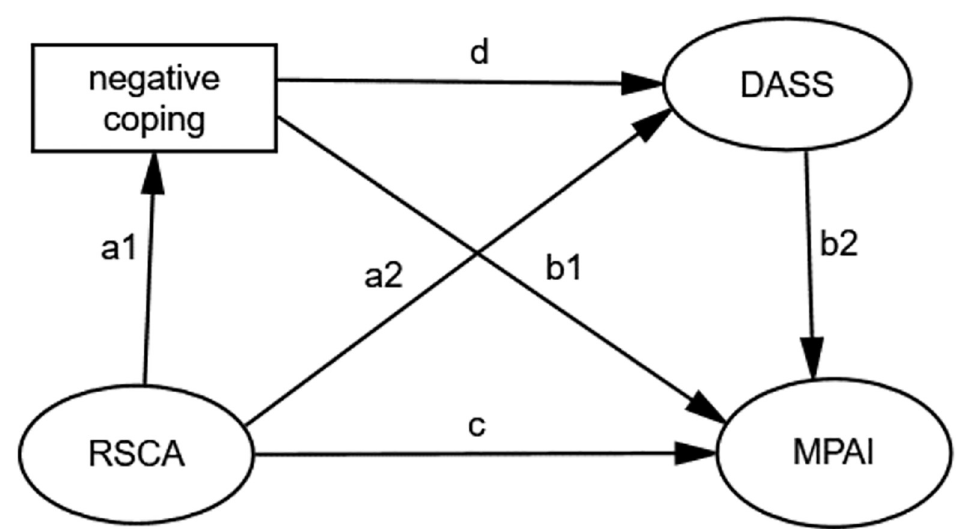
Fig 1. Hypothesized model. Notes: mobile phone addiction index (MPAI); depression, anxiety, and stress scale with 21 items (DASS-21); Resilience Scale for Chinese Adolescents (RSCA); Simplified coping style questionnaire (SCSQ).